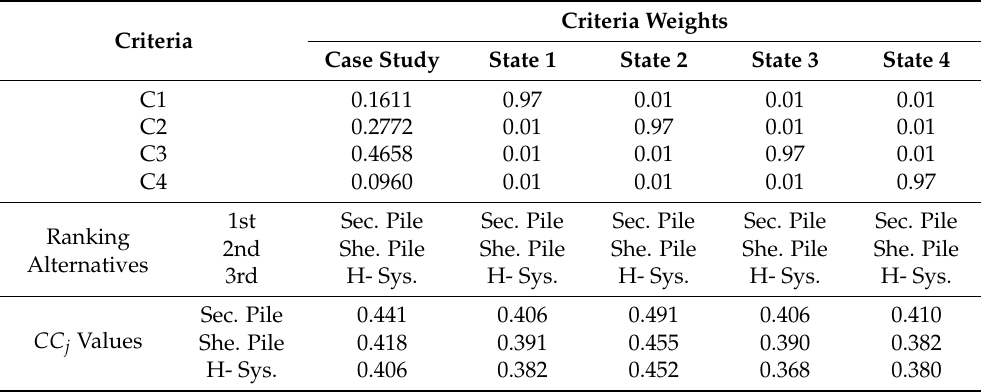
Table 2. Sensitivity analysis for effects of various weights of the identified